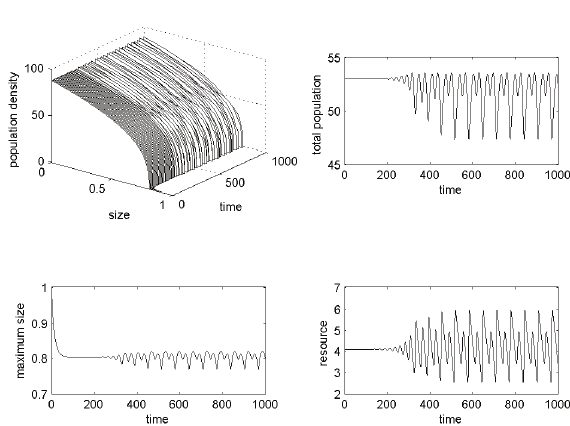
Fig. 1. Evolution of the numerical solution. Case of a bounded unstable steady state.